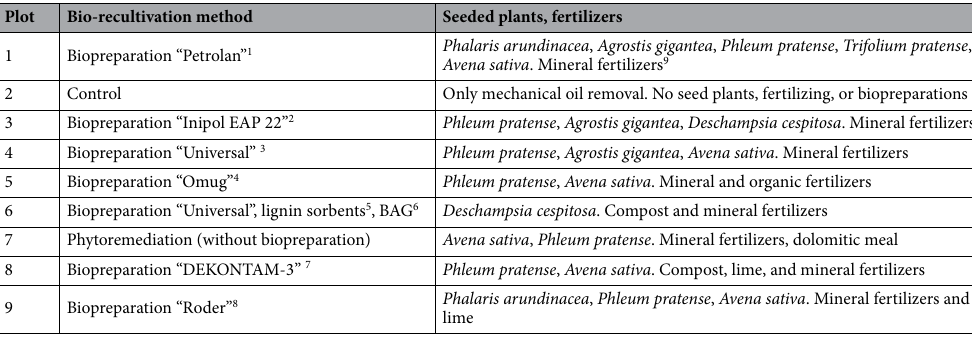
Table 1. Brief description of the remediation methods 39 . 1 “Petrolan” Design—commercial confidentiality. Developer—“Priborservis”, Tomsk, Russia. 2 “Inipol EAP 22”. Design—commercial confidentiality. Developer— “TotalFinaElf”, France. 3 “Universal”. Design—yeasts Rhodotorula glutinis and bacteria Rhodococcus egvi, Rhodococcus erythropolis, Pseudomonas fluorescens . Developer—Institute of biology Komi Science Center, Syktyvkar, Russia. 4 “Omug”. Design—oil-destructing microorganisms Bacillus subtilis and bacteria Rhodococcus sp. deposited on the organic fertilize surface. Developer—“Nika”, St. Petersburg, Russia. 5 Lignin sorbents—dried and crushed compost with embedded oil-destructing microorganisms isolated from the oil- contaminated soils of the study area 51 . 6 BAG—Biologically Active fertilizer-seeding granules on the compost basis with fertilizers and seeds of perennial herbs 52 . 7 “DEKONTAM-3”. Design—commercial confidentiality. Developer—«Dekonta a.s.», Czech Republic. 8 “Roder”. Design—bacteria Rhodococcus ruber и Rhodococcus erythropolis . Developer—Chemical Faculty of Moscow State University, Moscow, Russia 18,53,54 . 9 Mineral fertilizers—ANP (ammonium nitrate phosphate) fertilizer at a rate of 350 kg/ha. Fertilizer was introduced in 2002. Additional feeding was not carried out.